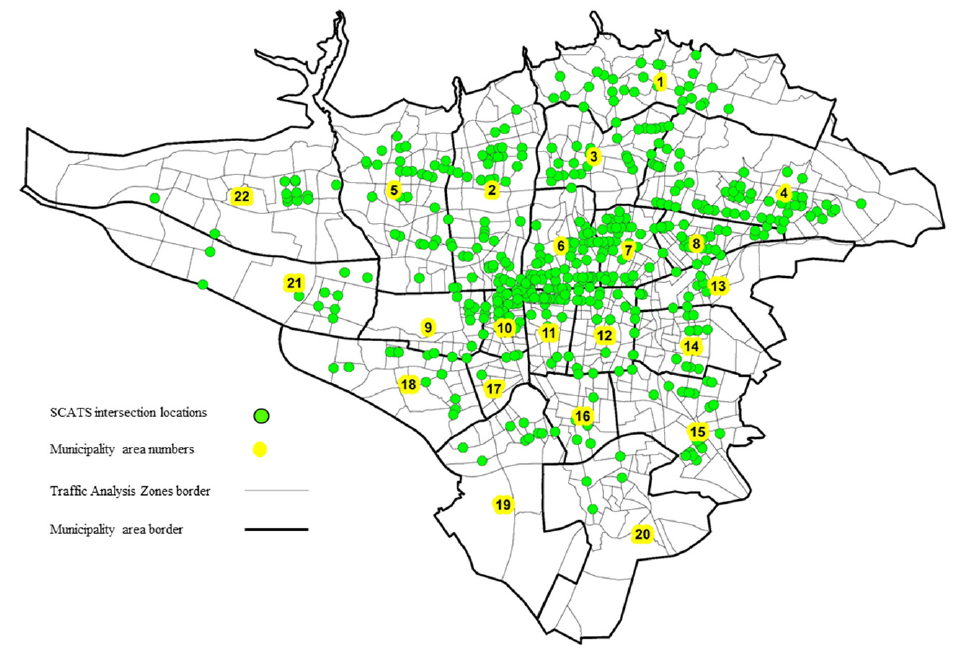
Figure 3. Location of adaptive real-time traffic signal control systems.